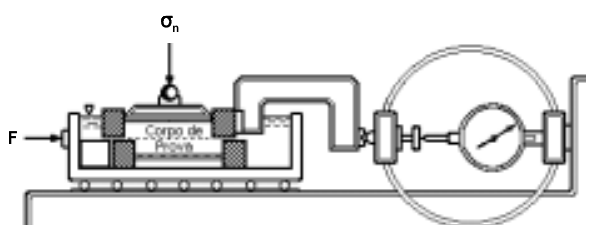
Figura 1. Representação esquemática do ensaio de cisalhamento direto.